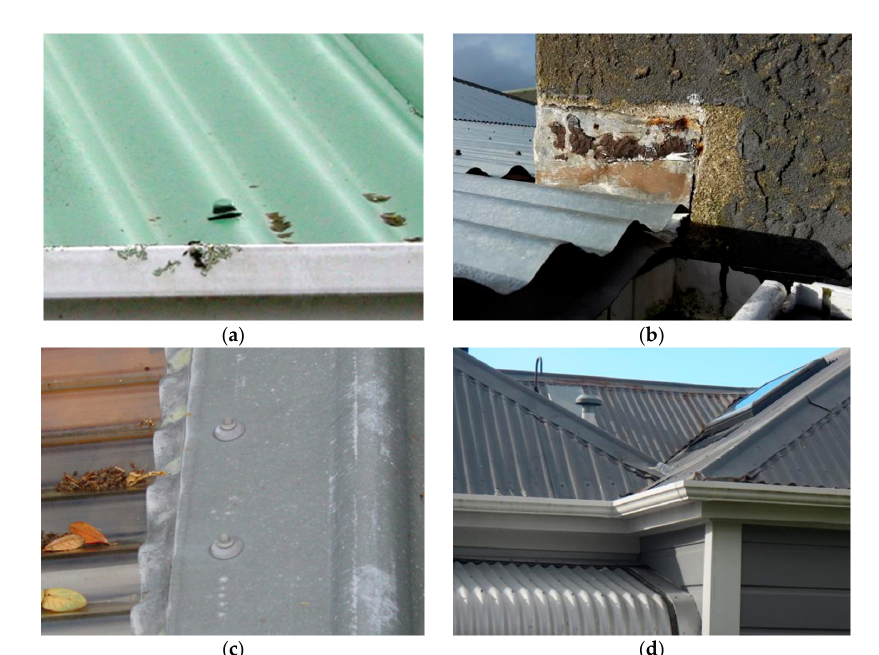
Figure 4. ( a ) Old lead head nail, Site 4; ( b ) Lead flashing abutting chimney, Site 6; ( c ) Soft lead edging to ridge cap, Site 1; and ( d ) Roof at Site 5, showing areas of new roof cladding at lower left (unpainted galvanised steel with modern screw fasteners) and original roof cladding on main roof (painted galvanised steel with lead fixings and flashing).